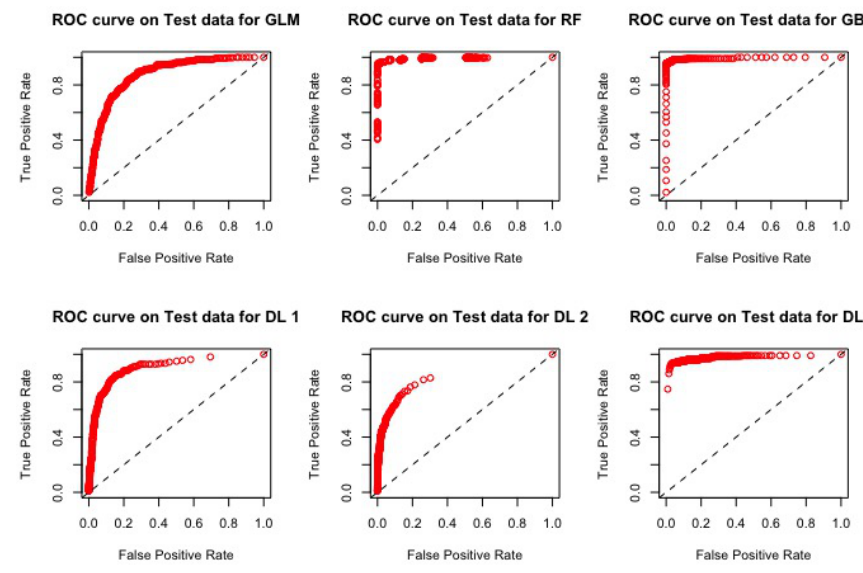
Figure 3. ROC curves for the models M1, M2, M3, D1, D2 and D3 using 181 variables with the test set.